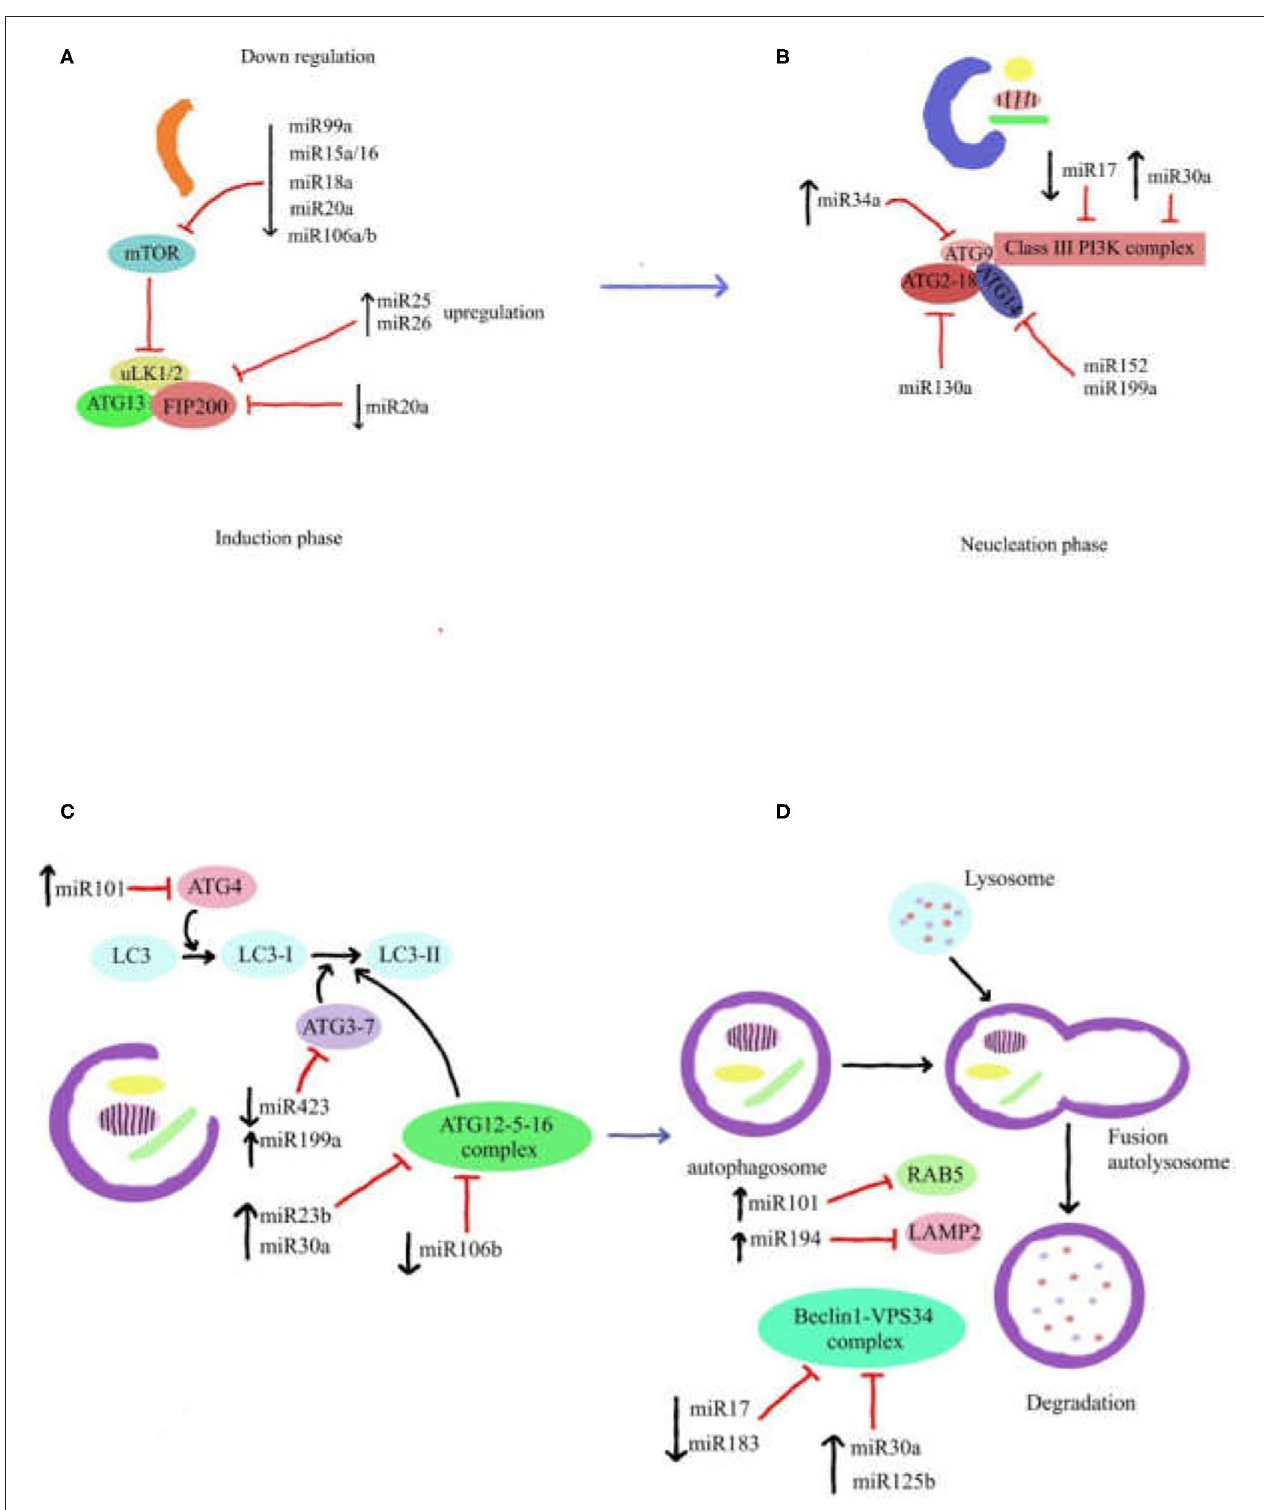
FIGURE 2 | Role of miRNAs in autophagy pathway. Autophagy process is illustrated in four steps (A–D) , in which miRNAs affect each of autophagy components. The various roles of miRNAs demonstrate that miRNA gene expression can regulate components of autophagy pathway. Some of these miRNAs have important role in each step of autophagy process. Autophagy pathway can be also inhibited by downregulation and/or upregulation of miRNAs gene expression.